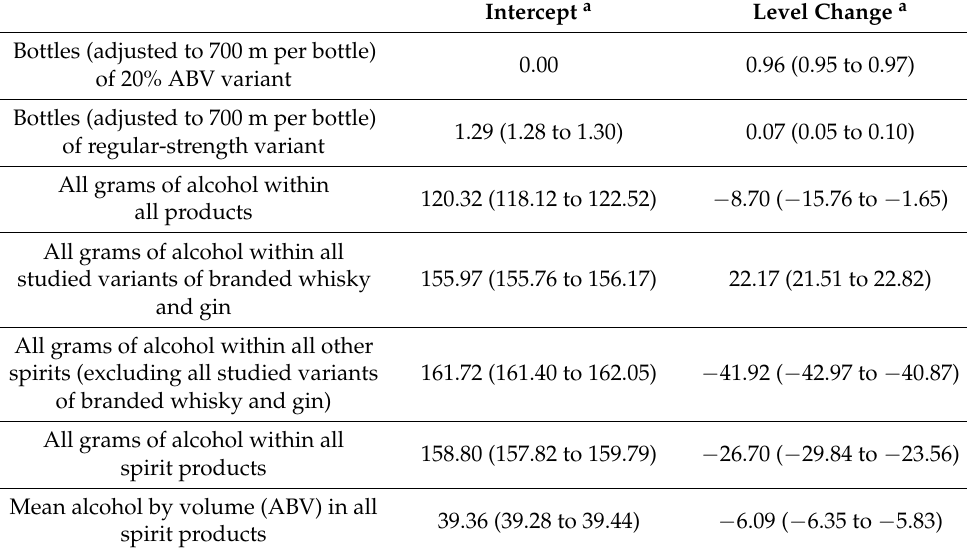
Table 3. Unstandardized coefficients from interrupted time series ARIMA regression models for intercept and level change associated with the introduction of 20% ABV variants of same-branded whisky or gin for 30 households that had purchased at least one bottle of the 20% ABV variants, controlling for changes in purchases by 1178 households that had purchased the regular-strength but not the 20%